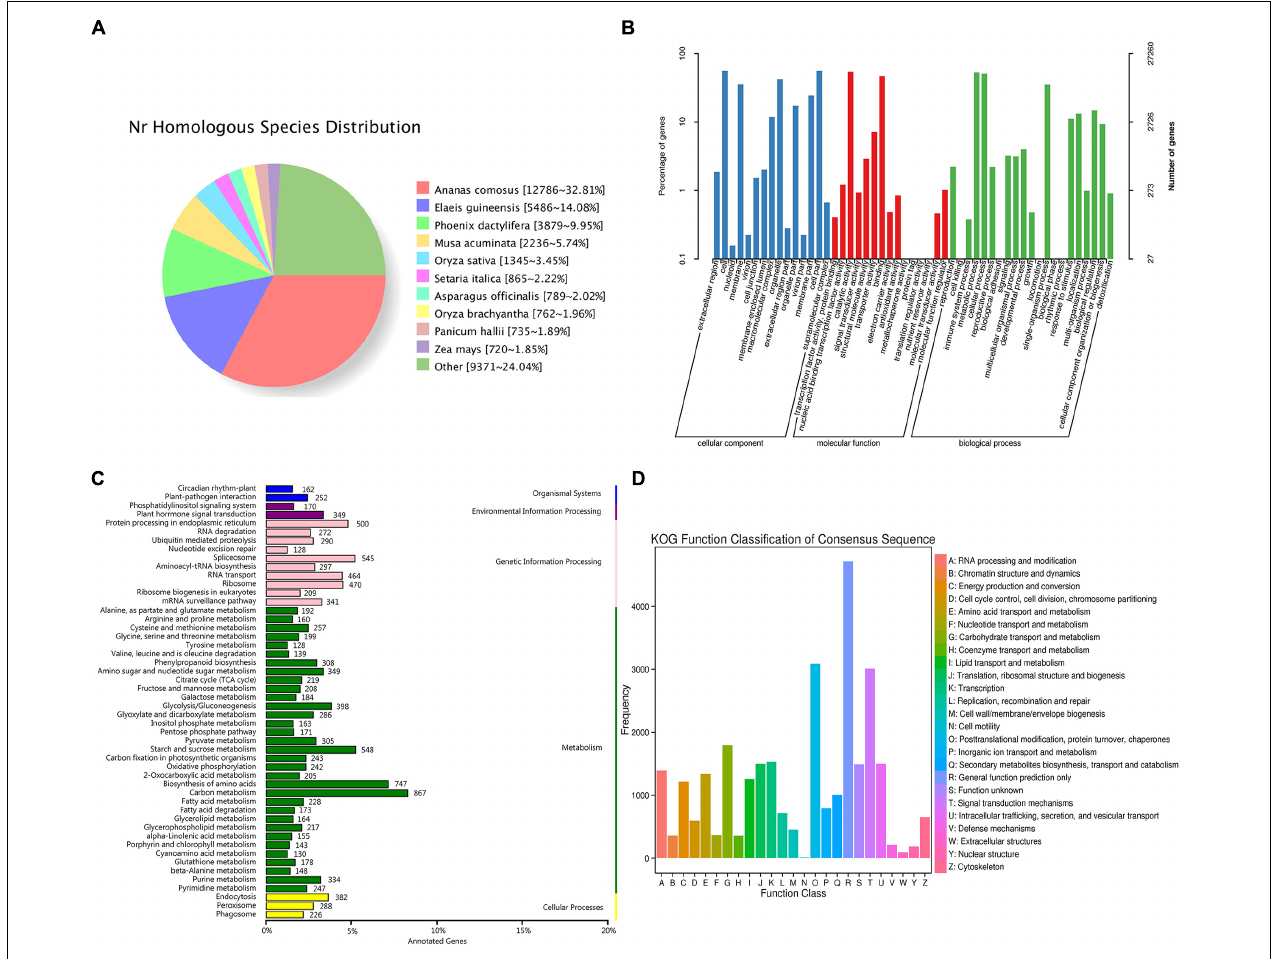
FIGURE 5 | Functional annotations for Carex rigescens transcripts. (A) NR homologous species distribution diagram of transcripts. (B) Distribution of gene ontology terms for all annotated transcripts. (C) Kyoto encyclopedia of genes and genomes pathway classification of transcripts. (D) EuKaryotic ortholog groups function classification of